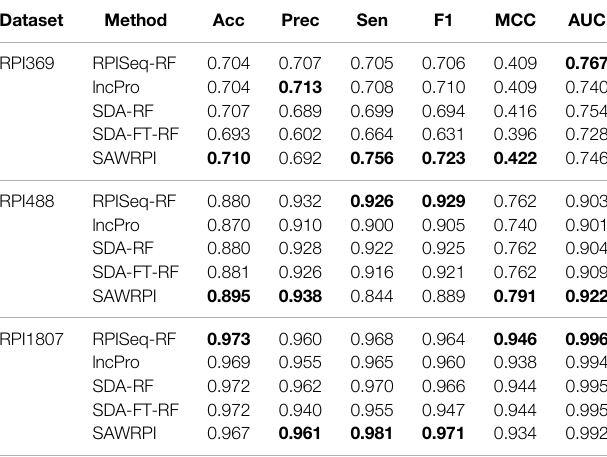
TABLE 7 | Results of comparing with state-of-the-art methods on three datasets. Dataset